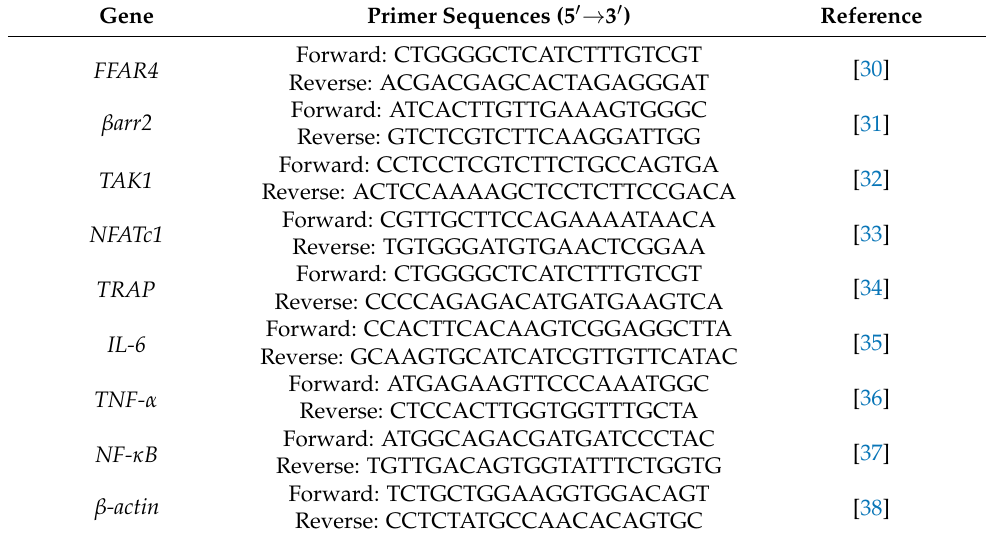
Table 1. Primer sequences of the genes for RAW264.7 cells in RT-qPCR. Gene